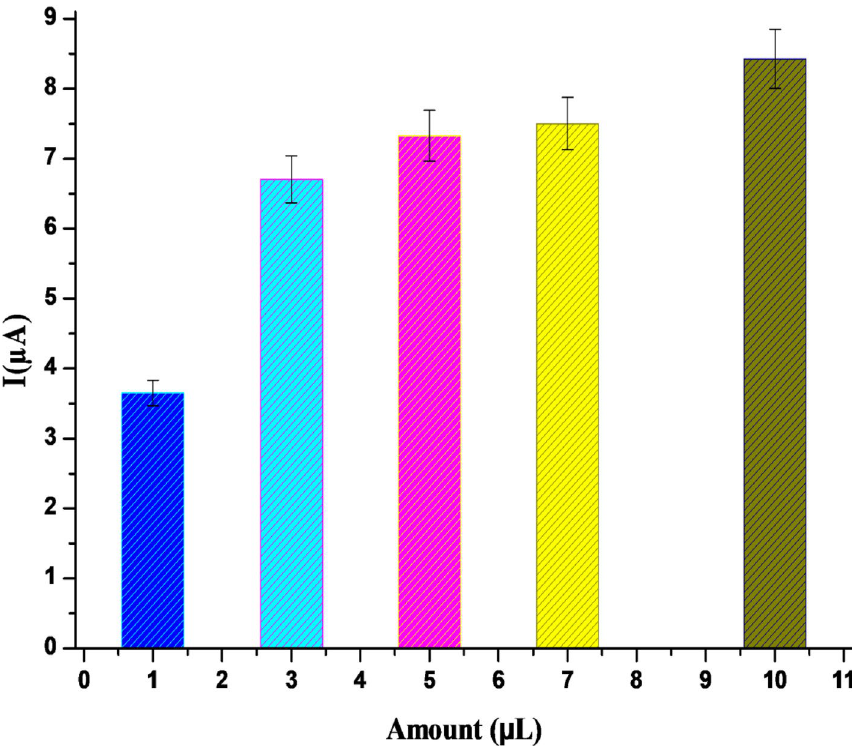
Figure 9. Effect of Ru@VC amount on IDA response using Ru@VC/GCE by AdSDPV method with 0.0 mV accumulation potential, 30 s accumulation time.